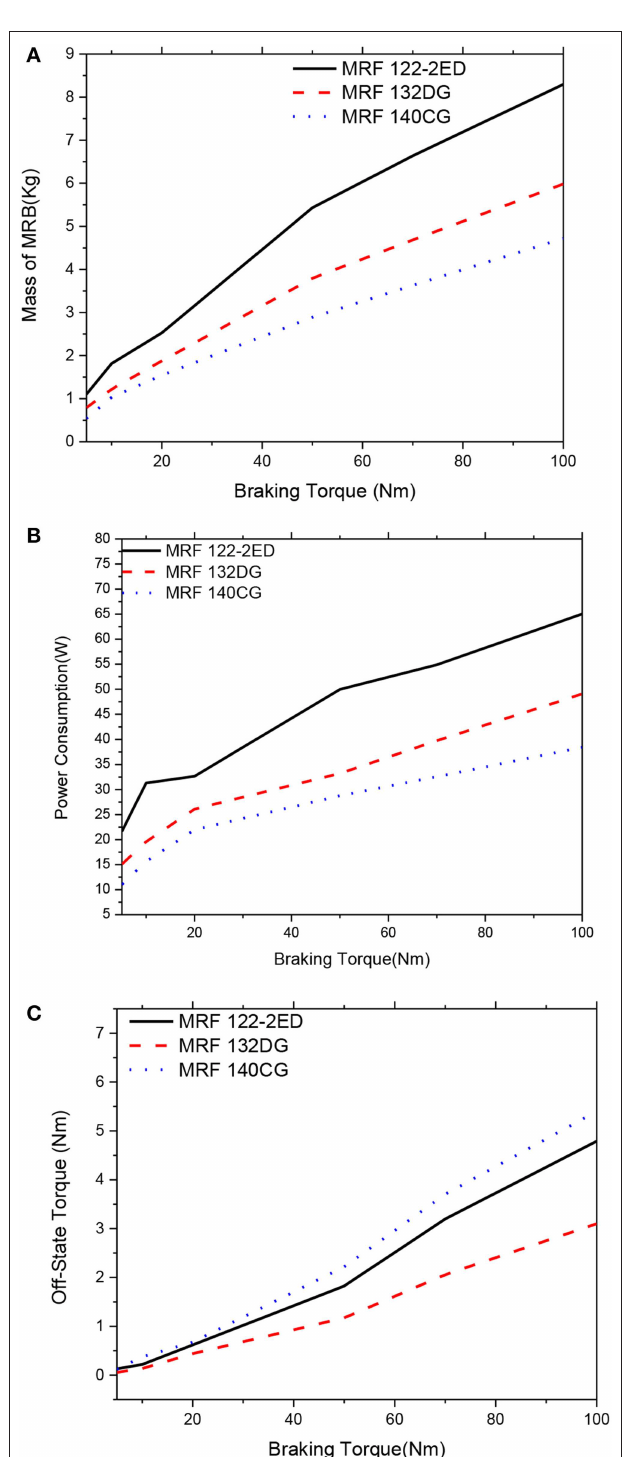
FIGURE 10 | Mass optimization results of the MRBs as a function of braking torque of conventional MRB, d = 1.0mm. (A) Mass as a function of braking torque, (B) Power consumption as a function of braking torque, (C) Off-state torque as a function of braking torque.